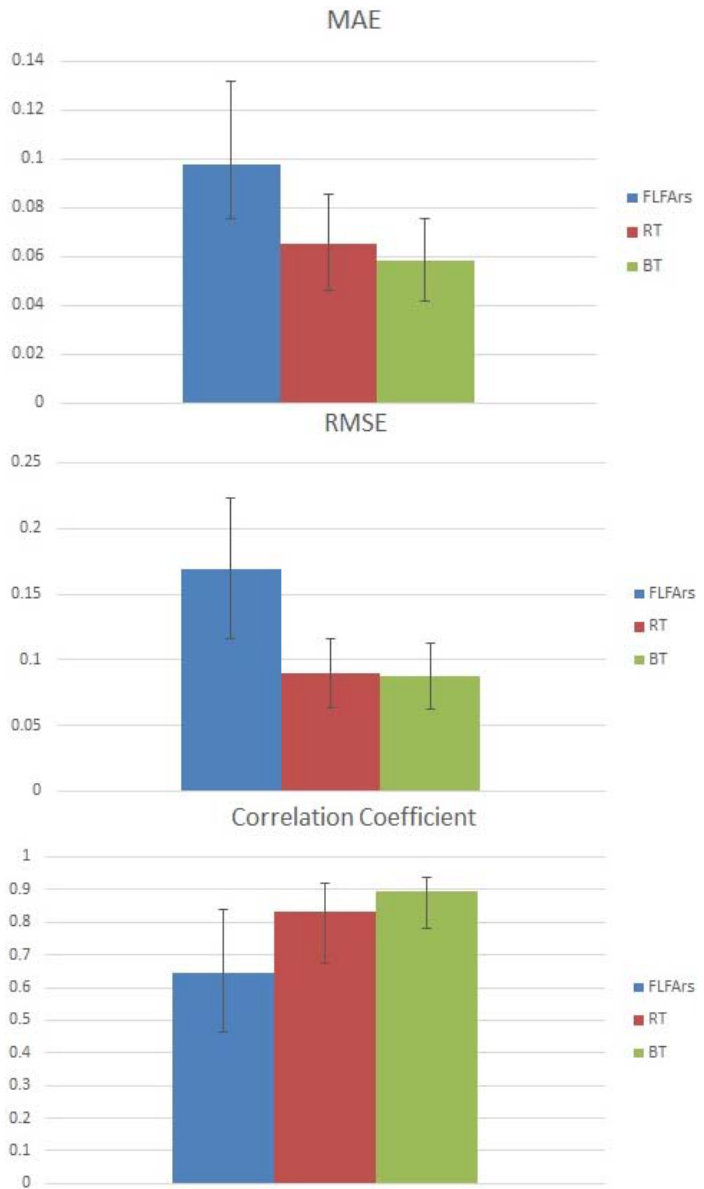
Figure 11. Comparison of the flood damage estimation models (FLFA rs : Australian stage-damage function, RT: regression tree, BT: bagging decision trees). Bar graphs represent the converged average values of the results, calculated over 200 sets of data samples, and the error bars show the spread of the results.